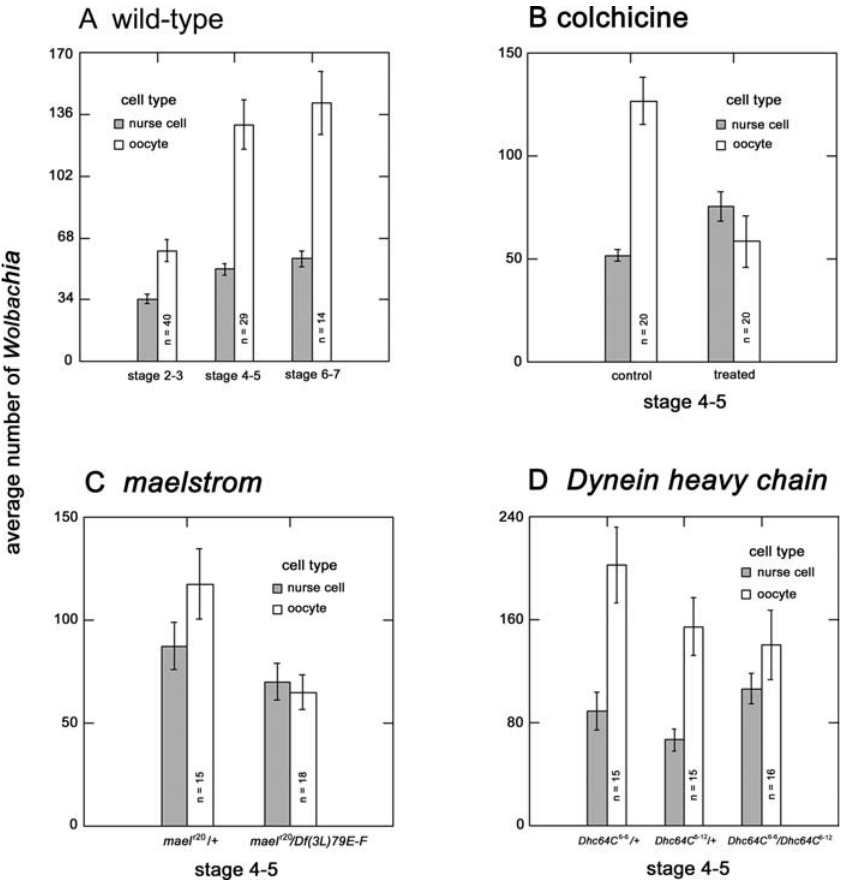
Figure 4. Manipulation of Specific Host Cytoskeletal Factors Affects Wolbachia Numbers (A) Mean Wolbachia numbers for the average nurse cell and the oocyte through mid-oogenesis. (B) Mean Wolbachia numbers for the average nurse cell and the oocyte for colchicine-treated and control (untreated) egg chambers. (C) Mean Wolbachia numbers for the average nurse cell and the oocyte for maelstrom r20 / þ and maelstrom r20 / Df (3L) 79E-F egg chambers. (D) Mean Wolbachia numbers for the average nurse cell and the oocyte for Dhc64C 6–6 / þ , Dhc64C 6–12 / þ , and Dhc64C 6–6 / Dhc64C 6–12 egg chambers. Error bars represent the standard error of the mean. DOI: 10.1371/ journal.ppat.0010014.g004